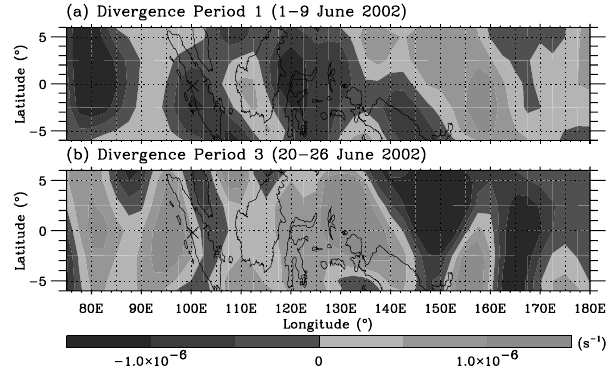
Fig. 11. Longitude-latitude plots of divergence at 1000hPa av- eraged during (a) Period 1 and (b) Period 3. Horizontal wind at 1000hPa are derived from NCEP/NCAR reanalysis, and bandpass filtering with cutoffs at 10 days and 60 days and 5 ◦ × 5 ◦ running mean are applied to